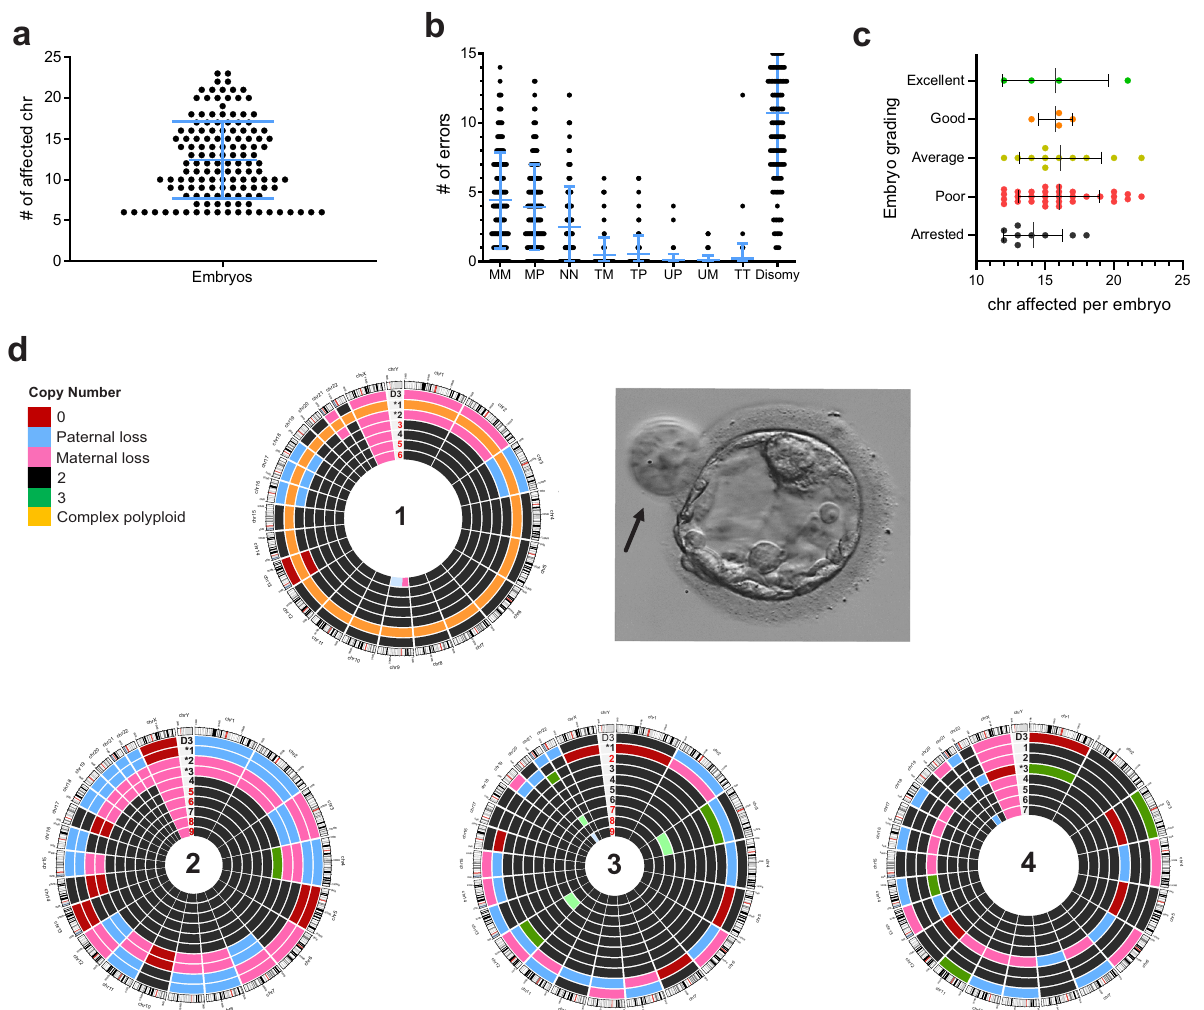
Fig. 3 Hallmarks of putative tripolar division in cleavage embryos and blastocysts. a Each dot represents an embryo ( n = 138) with corresponding number of affected chromosomes in the genome, with a mean of 12.41 ± 4.74 (±SD) affected chromosomes per embryo (chromosomes = 23). b Rate of different chromosome missegregations in embryos with multiple aneuploidy (MM monosomy maternal, MP monosomy paternal, NN nullisomy, TM trisomy maternal, TP trisomy paternal, UM maternal UPD, UP paternal UPD, TT tetraploidy). c Developmental fate of embryos with putative tripolar division (Arr arrested, EB early blastocysts, Good good-quality blastocyst, Poor poor- quality blastocyst). d Circus plots representing genomic constitution of four blastocysts, derived from cleavage embryos with putative tripolar division. Results of day-3 biopsy are indicated as D3. Asterisk indicates large potentially excluded cells (as those indicated by arrow in Embryo 1), compared to other cells in the blastocyst. Numbers in red in Embryos 1, 2, and 3 indicate that a clump of cells (on average 2 – 4 cells) was tubed together and analysed. Light green (in Embryo 3) and light blue (in Embryo 1) indicate mosaic gain and loss,